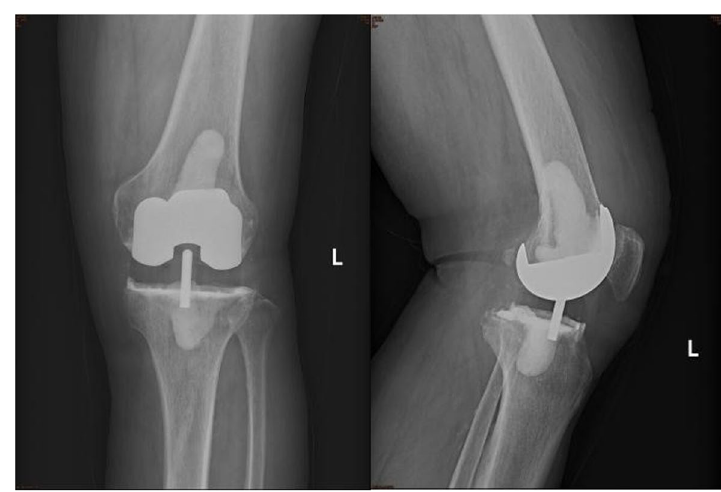
Fig. 5 The new prosthesis was combined with high-concentration bone cement for a 1.5-stage exchange, using a Press Fit Condylar femoral component (PFC, DePuy Synthes, Warsaw, IN, USA) and a constrained polyethylene